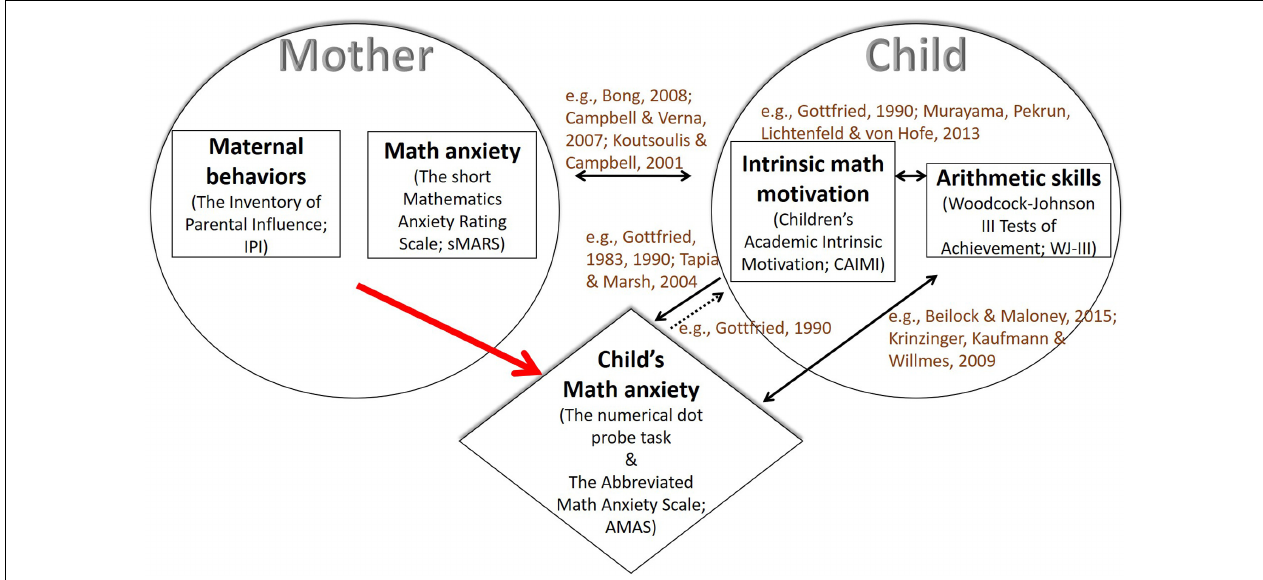
FIGURE 1 | The scientific framework for the present investigation. The rhombus represents the dependent variable in the present study and the red arrow represents the relationship that was the focus of the study. Broken arrows represent weaker relations compared to the bold ones. In brackets is the methodological tool that was